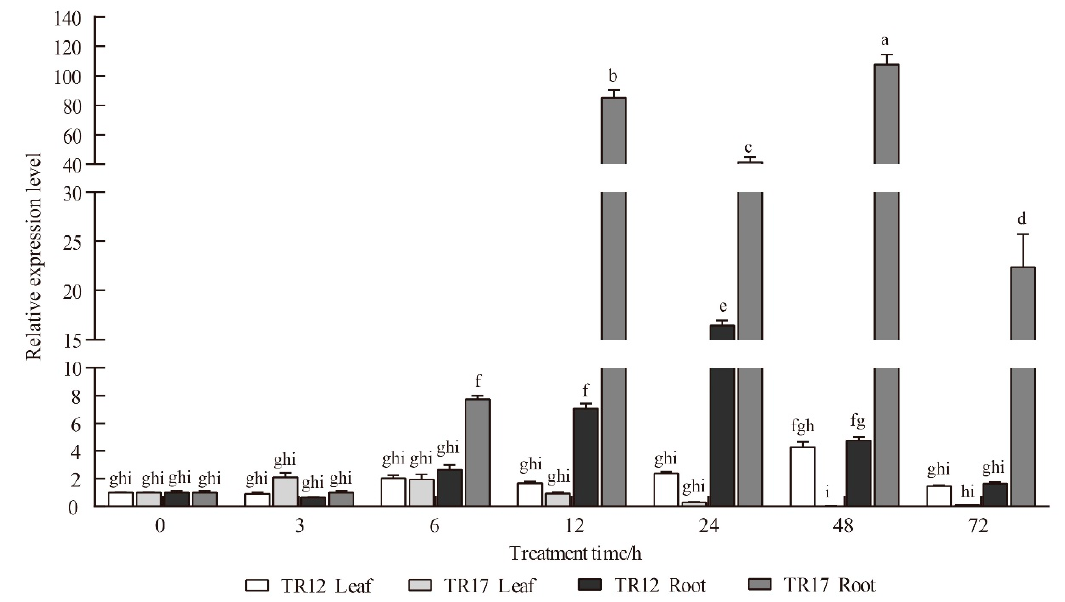
Figure 4. Expression profiles of RsSOS1 in radish leaf and root under salt stress. Error bars indicate SD, letters represent significant differences at p < 0.05 level based on Duncan’s test.